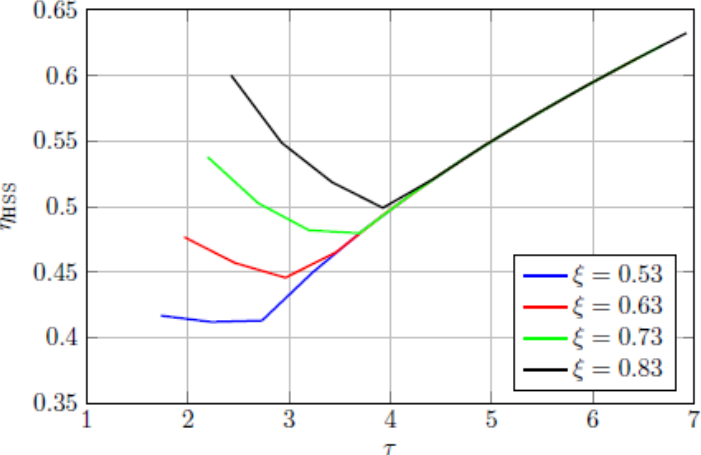
Figure 5. Efficiency of the regenerated HSS system as a function of τ for different values of ξ in the range of 0.53 to 0.83. The plot refers to a system with β c = 20, β e = 0.9 * β c , η el = 0.80, η t = 0.9, η c = 0.9, and η cc = 0.98.